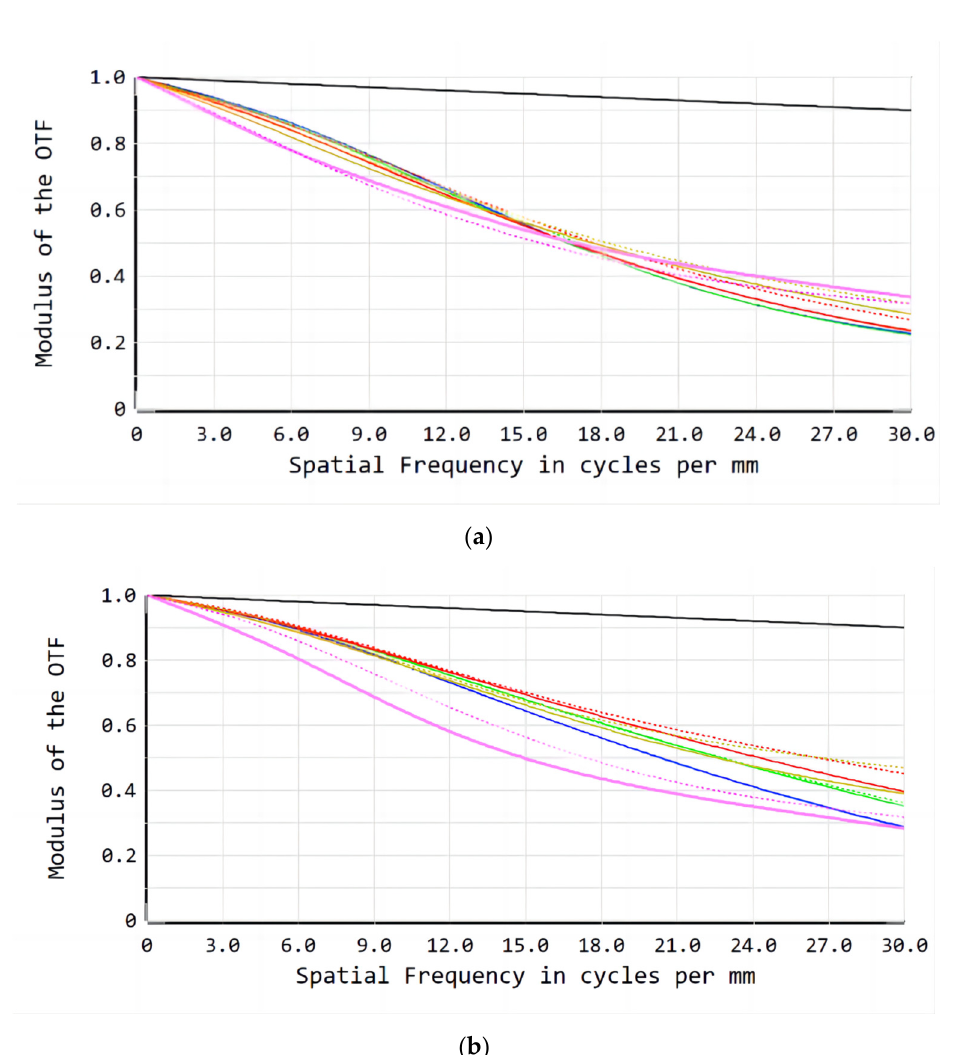
fractive lens system.